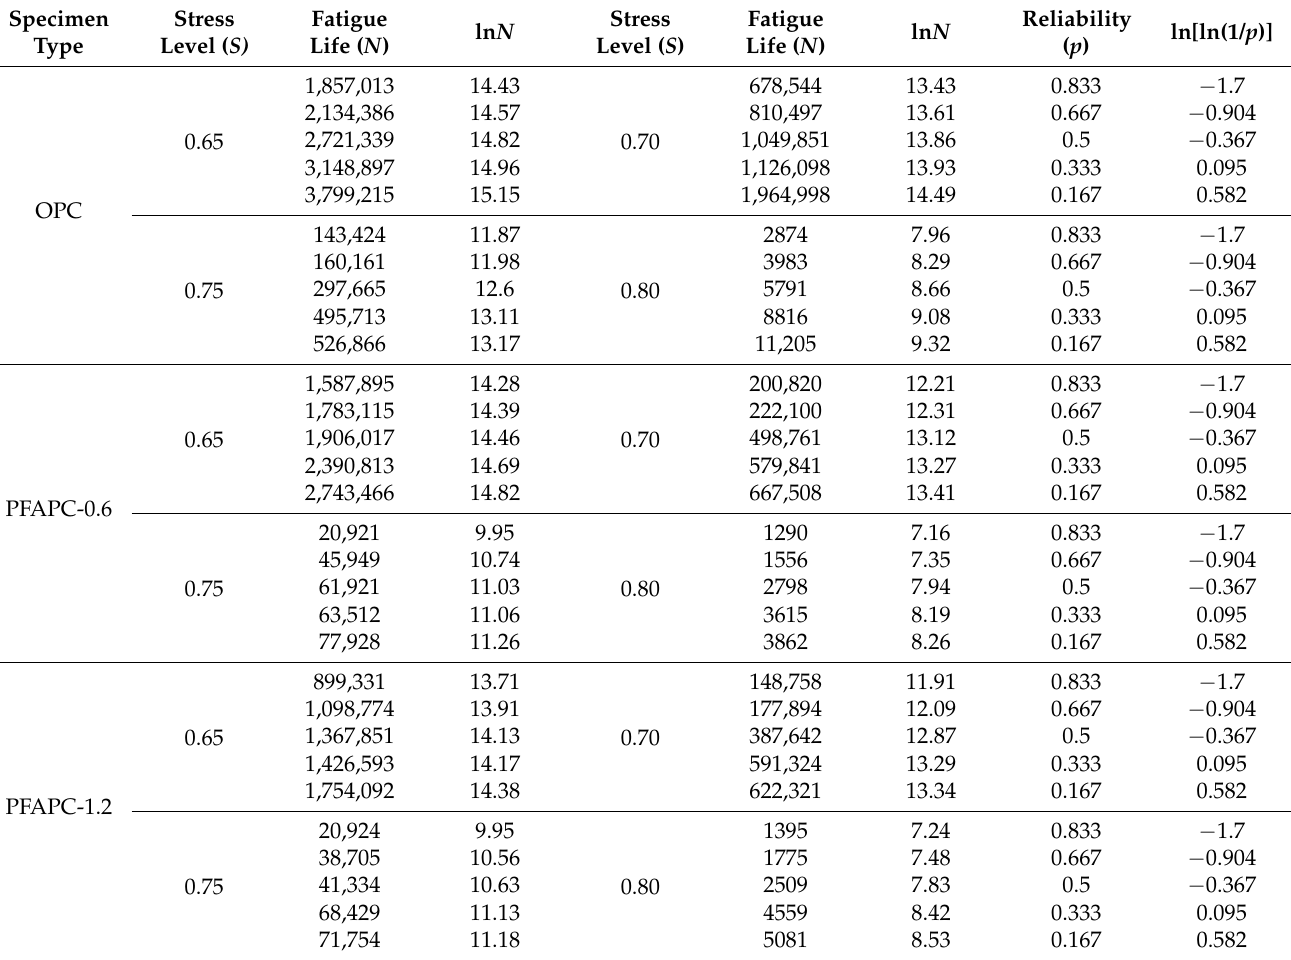
Table 5. Fatigue test